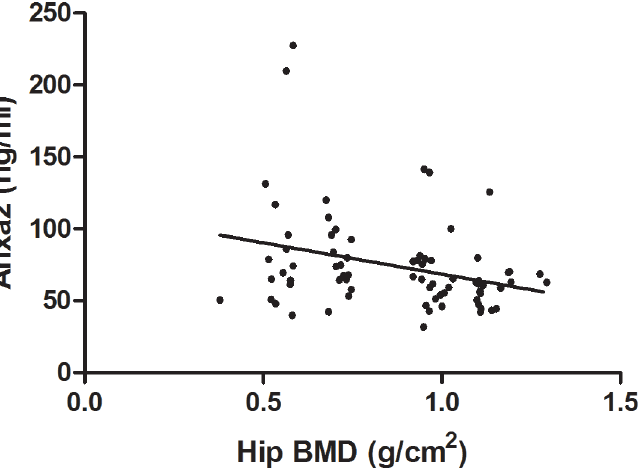
Fig 2. Plasma Anxa2 protein level was negatively correlated with hip BMD in Sample 2. The correlation between Anxa2 protein level in plasma and hip BMD was analyzed with Pearson correlation analysis (r = -0.302, P = 0.0084).